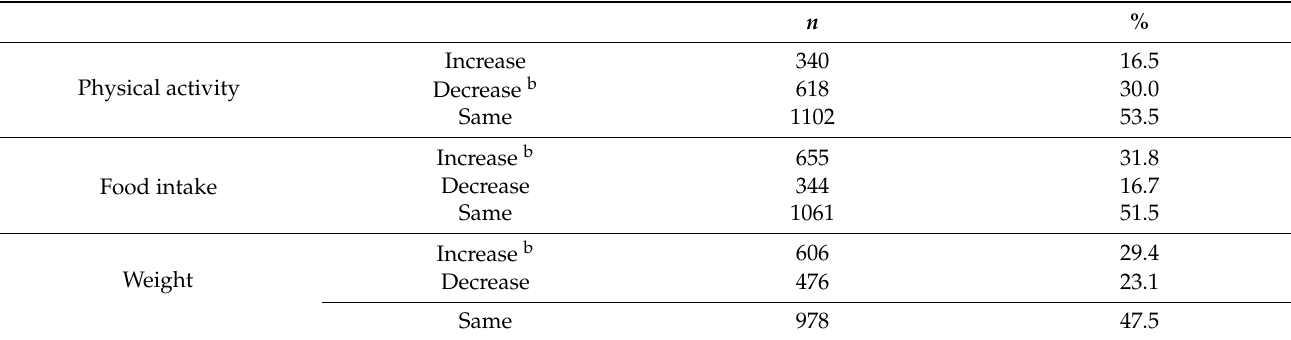
Table 2. Description of dietary and lifestyle behaviors changes during COVID-19 pandemic among the study population ( n =